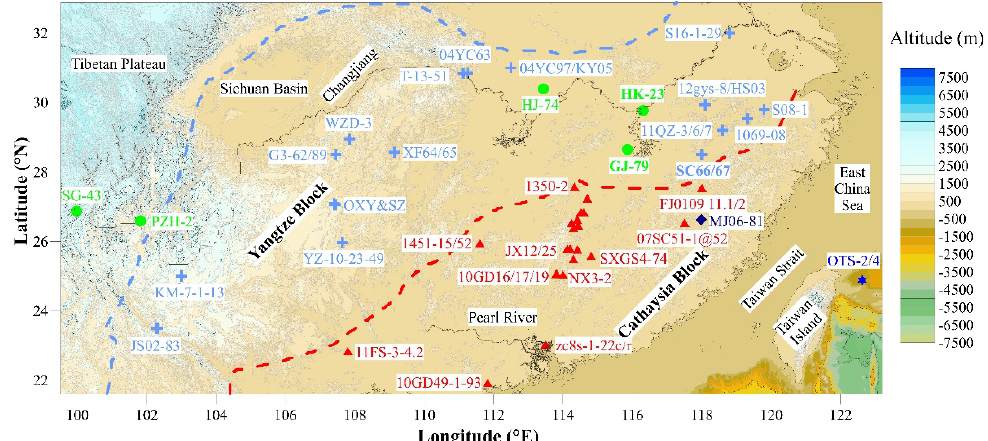
Figure 8. Distribution of Paleoarchean detrital zircon grains in the south China and East China Sea. Grains in the Yangtze Block, Cathaysia Block, Yangtze River Basin, and Minjiang are marked by light blue cross, red triangle, green circle, and dark blue diamond, respectively. The location of the Yangtze Block and the Cathaysia Block modified from references [33–35]. Please refer to Table S3 and references therein for detailed data of ages and location. The light blue and red dotted lines roughly define the position of the Yangtze Block and the Cathaysia Block, respectively. Topographic data comes from https://www.gebco.net (accessed on 1 December 2021).